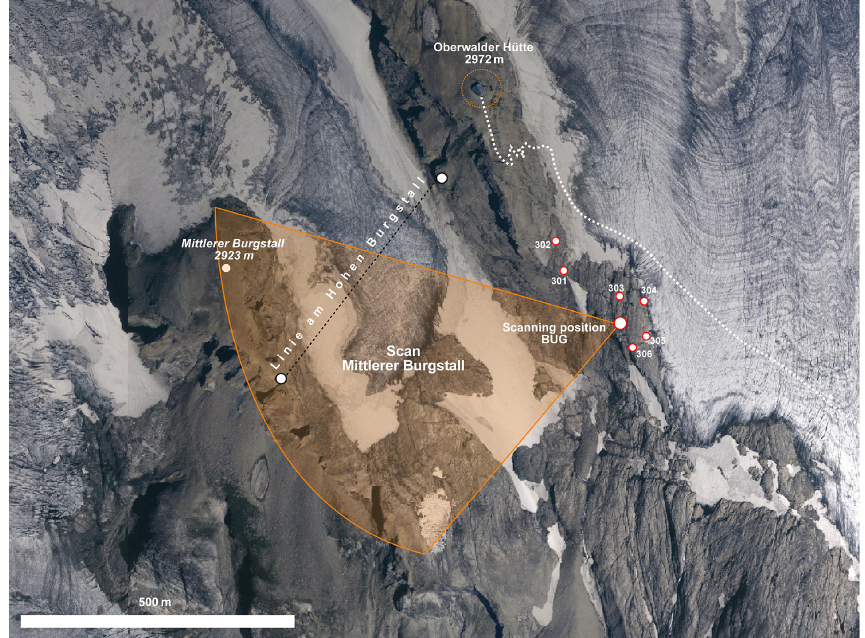
Figure 6. Configuration at scanning position Burgstall (“Scanning position BUG”). BUG is serving two objects, Mittlerer Burgstall and Hoher Burgstall rockfall area. Codes: 301–306: reference points; “Linie am Hohen Burgstall” cross section of traditional glacier surveying. Orthoimage from 1998, Hohe Tauern National